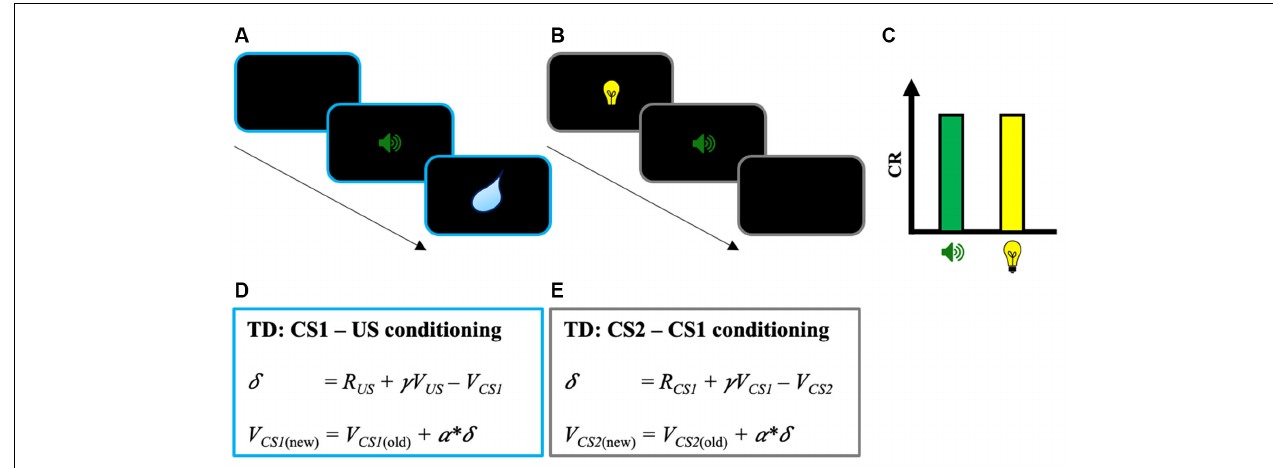
FIGURE 1 | Illustration of the second-order conditioning procedure. (A) Phase 1: First-order conditioning between a stimulus (CS1—sound) paired with an unconditioned stimulus (US—water). (B) Phase 2: Second-order conditioning between a second stimulus (CS2—light) paired with the previously paired stimulus CS1. (C) Classic results found in the second-order conditioning task with the conditioned response (CR) evoked both by CS1 and CS2. In sensory preconditioning, the procedure is similar except that phases 1 and 2 are inversed. (D) TD learning for the first-order conditioning phase with change in CS1’s predicted value V CS1 . Note that V US is zero because of the absence of predicted value at the time of the US. Because R US is positive, the pairing between CS1 and the US results in a positive δ (i.e., R US − V CS1 > 0), and the acquisition of predicted value from CS1 through the update of V CS1 ( V CS1(new) = V CS1(old) + α * δ ). (E) TD learning for the second-order conditioning phase with change in CS2’s predicted value V CS2 . Note that R CS1 is zero because of the absence of reward at CS1. Here, the positive V CS1 learned during the first-order conditioning phase is sufficient to produce a positive δ (i.e., γ V CS1 − V CS2 > 0) and to increase the predicted value from CS2 ( V CS2 ). TD, Temporal